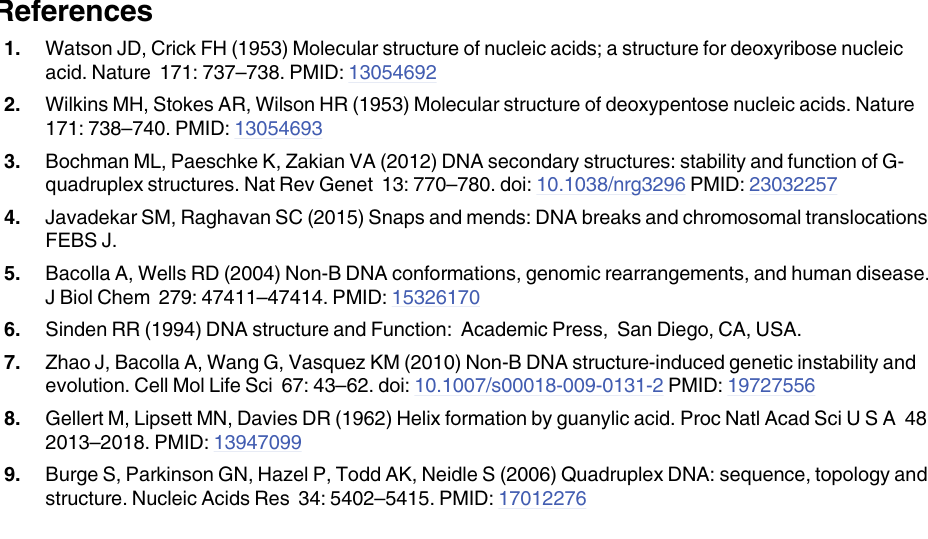
S4 Fig. Refolding of intra molecular GNG G-quadruplexes after heat denaturation. Radiola- beled oligomeric DNA with G-rich, C-rich or mutant DNA sequences were heat denatured and gradually cooled and then resolved in the presence (right panel) of KCl (100 mM) in the gel and running buffer. (A) Native EMSA for KD53 and KD52 ( SHOX oligomers, refer Fig 7A). (B) Native EMSA for MN89, RT17, KD47 and KD48 ( HIF1 alpha oligomers, refer Fig 6A, B). The substrate, intramolecular (Intra), and intermolecular (Inter) quadruplex structures are indicated. The red boxed ‘ Intra ’ indicate intramolecular G-quadruplex species involving GNG motifs. (JPG) S5 Fig. Evaluation of binding of purified recombinant Nucleolin to oligomer, KD52. (A) EMSA study to analyse binding of Nucleolin to KD52 (harbouring two G stretches and GNG motifs) and a scrambled control BTM6 in the presence of KCl (100 mM). (B) Binding studies using increasing concentration of Nucleolin (6, 12, 24, 60 ng) to KD52. (JPG) S6 Fig. Comparison of CD spectra of purified BG4 with KD52 and KD53. CD spectra of BG4 in presence of KD52 and KD53 (control) (shown in blue and red respectively). (JPG) S1 Table. Sequence of oligonucleotides used in the study.